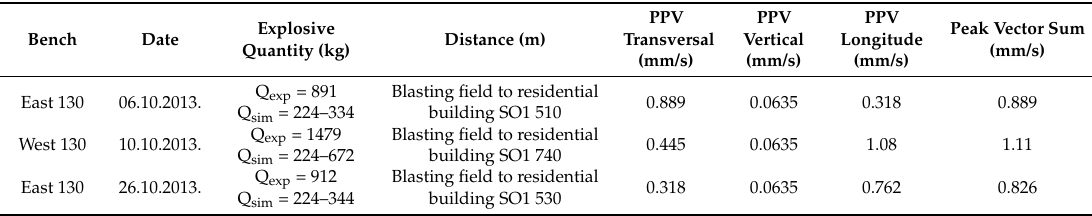
Table 4. Results of measurements of ground vibrations of the “Buvaˇc” open pit as verification of the above calculated